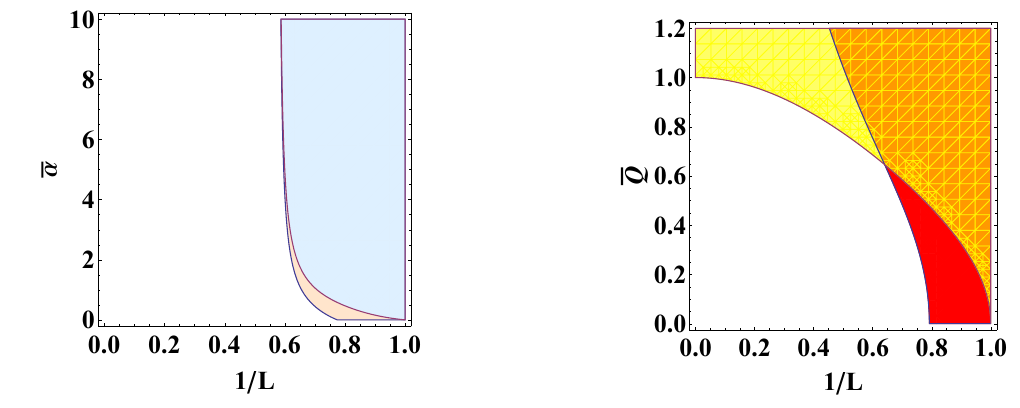
Figure 5 . The unstable region of the de Sitter charged Gauss-Bonnet black hole with ‘ = 2. The left panel shows the unstable region in ( L; (cid:11) ) plane, where the light blue region corresponds to Q = 0 and the light blue region plus the light orange region correspond to Q = 0 : 5. The right panel shows the unstable region in ( L; Q ) plane, where the yellow region plus the orange region correspond to (cid:11) = 0 and the red region plus the orange region correspond to (cid:11) = 0 :